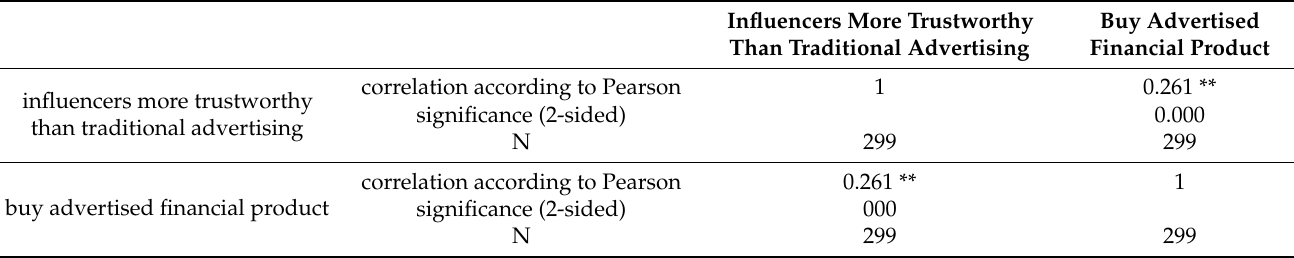
Table 7. Correlations